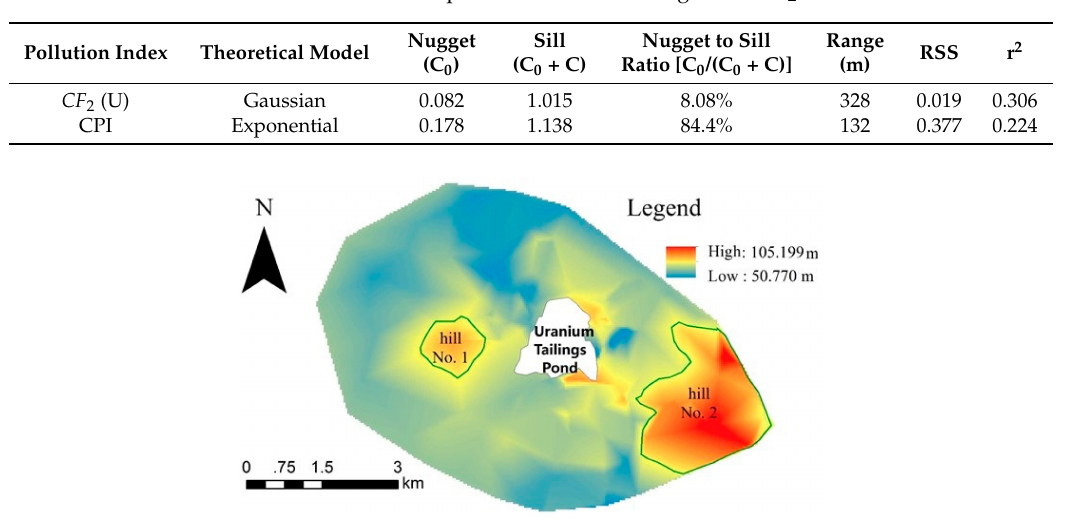
Table 7. Theoretical models and parameters of the variogram of CF 2 of U and CPI.